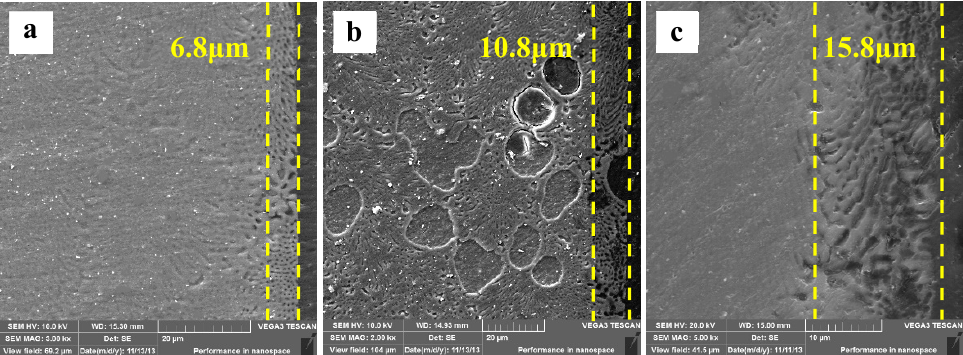
Figure 9. The corroded Mg–Al alloy specimen’s cross-sectional morphologies gained from HAc solution after immersion for different times: ( a ) 30 min, ( b ) 60 min, ( c ) 90 min.